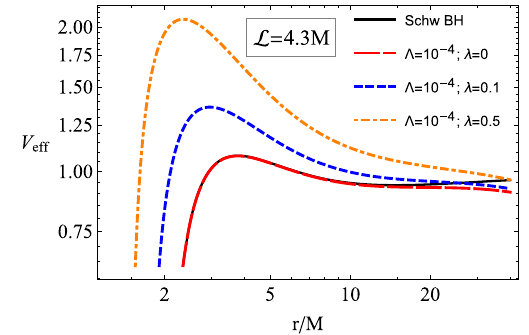
Fig. 1 Radial profiles of the effective potential for radial motion of test particles around the Schwarzschild–de Sitter BH surrounded by PFDM medium for different values of λ and Λ . Here we use Λ → Λ/ M 2 and λ → λ/ M